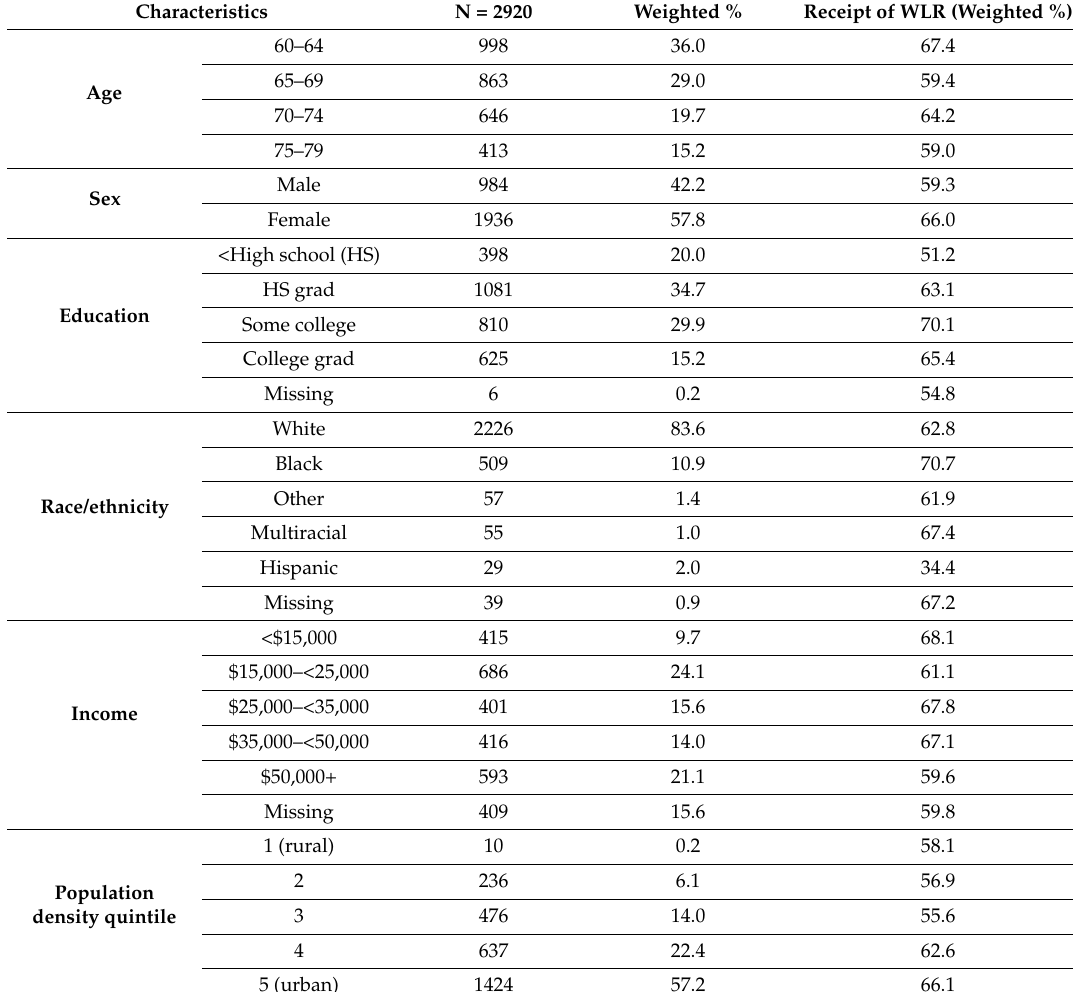
Table 1. Prevalence of receipt of weight loss recommendations (WLRs) by study characteristics among adults with arthritis and obesity, Behavioral Risk Factor Surveillance System,